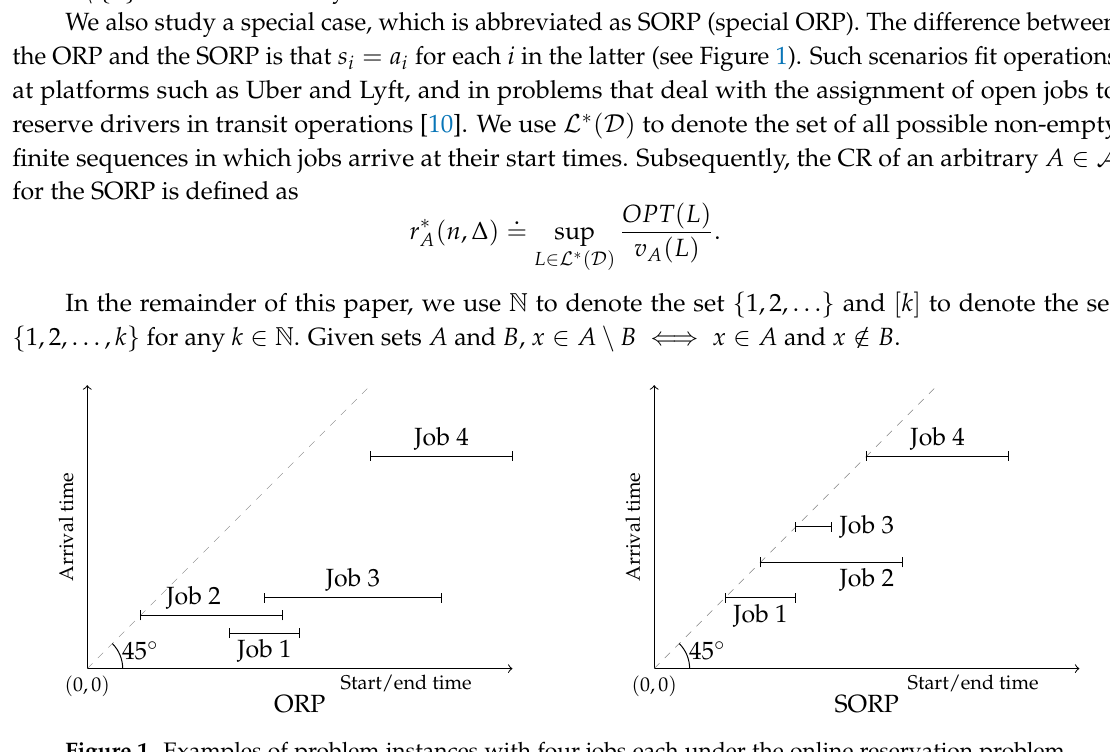
Figure 1. Examples of problem instances with four jobs each under the online reservation problem (ORP) and the special case of the ORP (SORP)